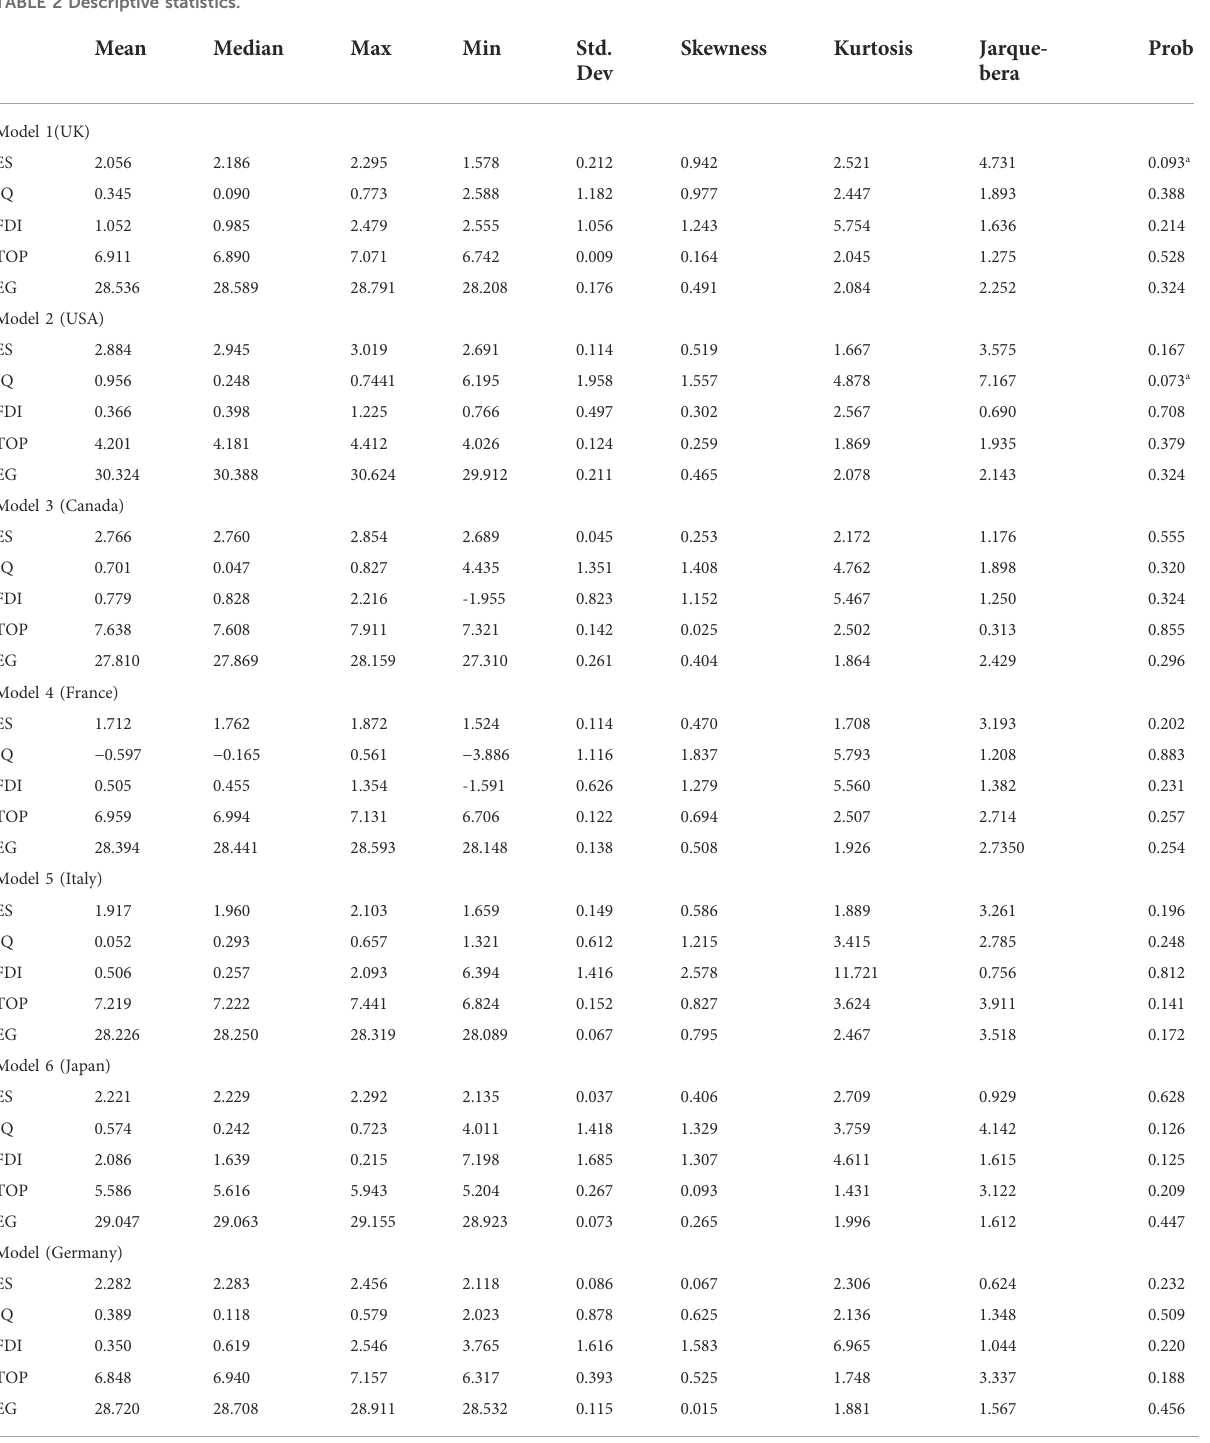
TABLE 2 Descriptive